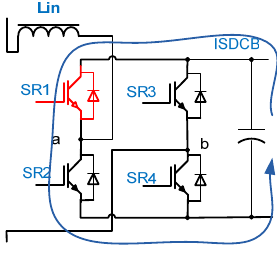
Figure 7. Schematic diagrams of input stage for fault B1 (IGBT SR1